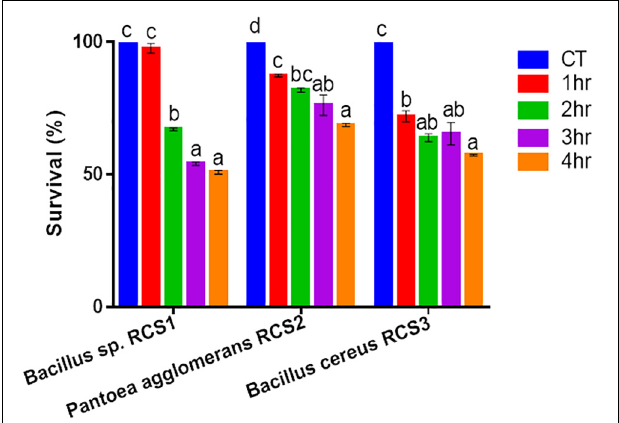
FIGURE 2 | Growth curves of isolated microorganisms. The growth curves were observed to determine the growth of these bacteria. The curves of the microbial growth were measured at 600 nm.